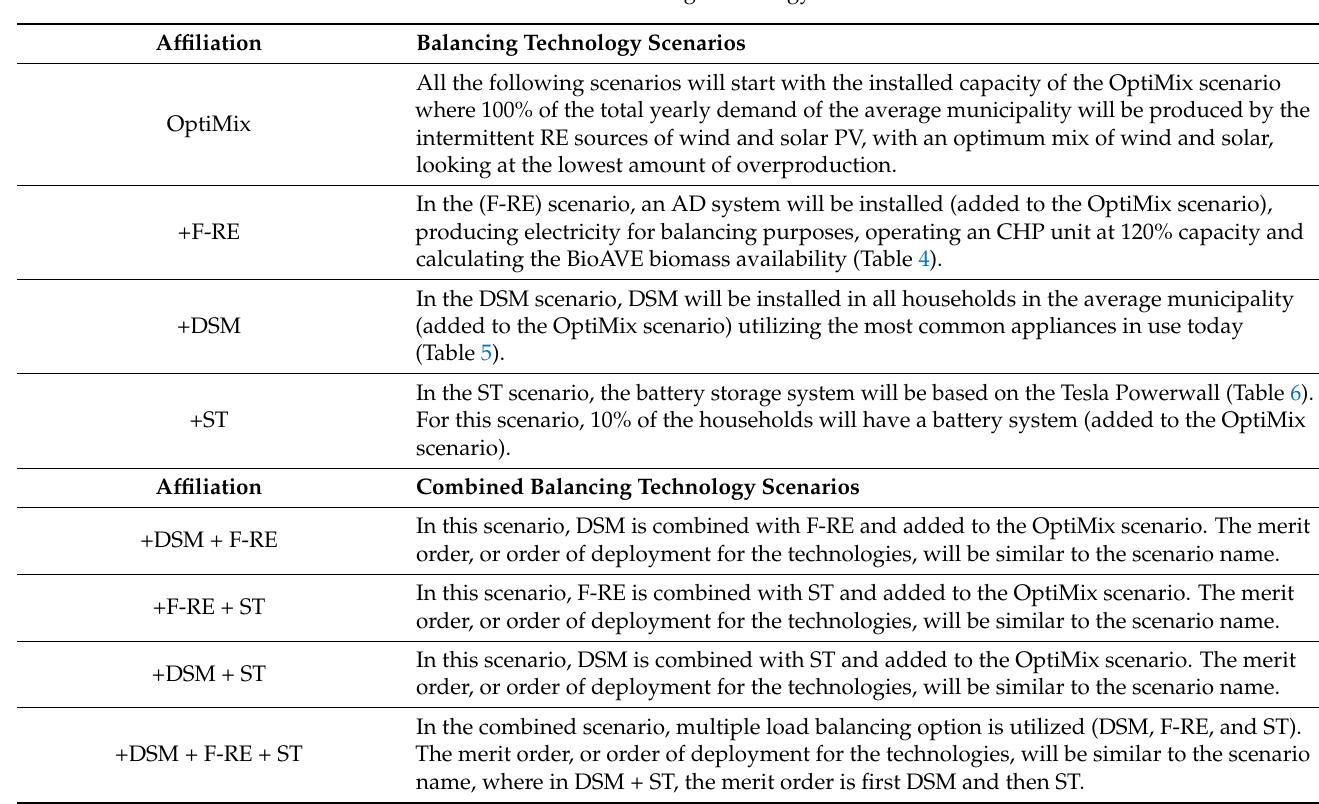
Table A11. Local balancing technology scenarios.